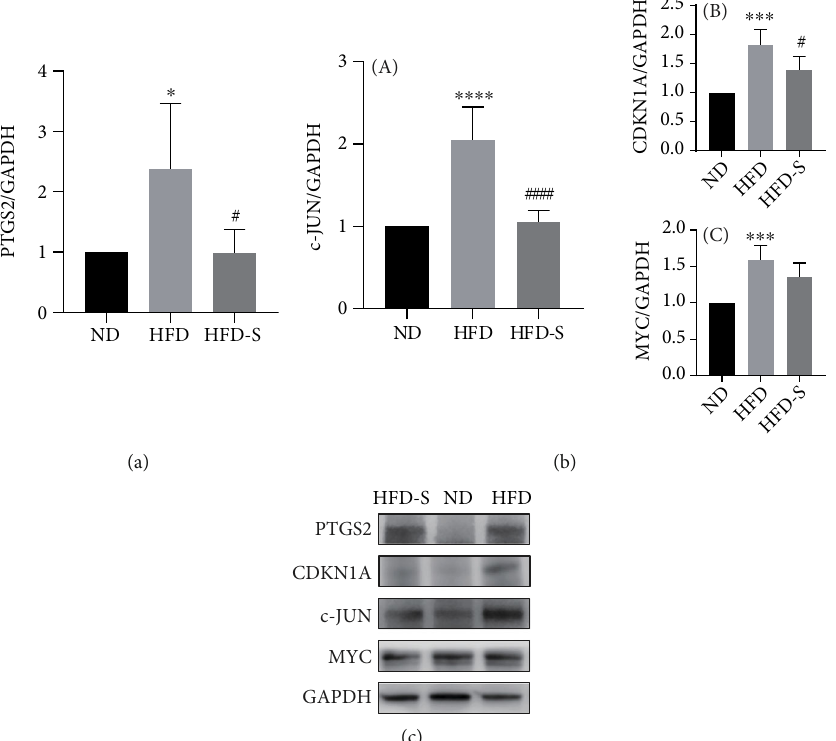
Figure 11: Western blotting results of hub target genes ( n = 5 , mean ± SD ). (a) The protein expression of the hub target gene PTGS2. (b) The expression of the hub target gene c-JUN and its interacting proteins. (A) Protein expression of the hub target gene c-JUN. (B) Protein expression of CDKN1A. (C) The protein expression of MYC. (c) The protein expression quantitation. ∗ p < 0 : 05 , ∗∗∗ p < 0 : 001 , and ∗∗∗∗ p < 0 : 0001 vs. ND; # p < 0 : 05 , #### p < 0 : 0001 vs.